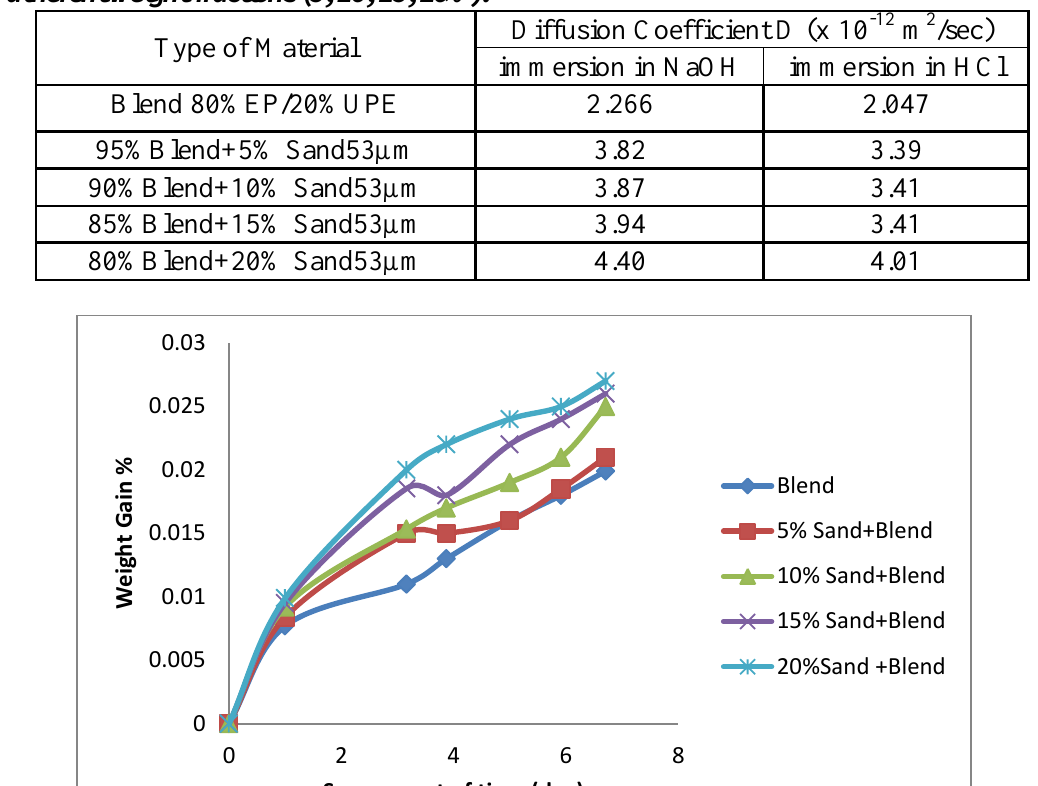
Table 5: Values of diffusion coefficient of EP/UPE reinforced with sand particles with different weight fractions (5, 10, 15, 20%).